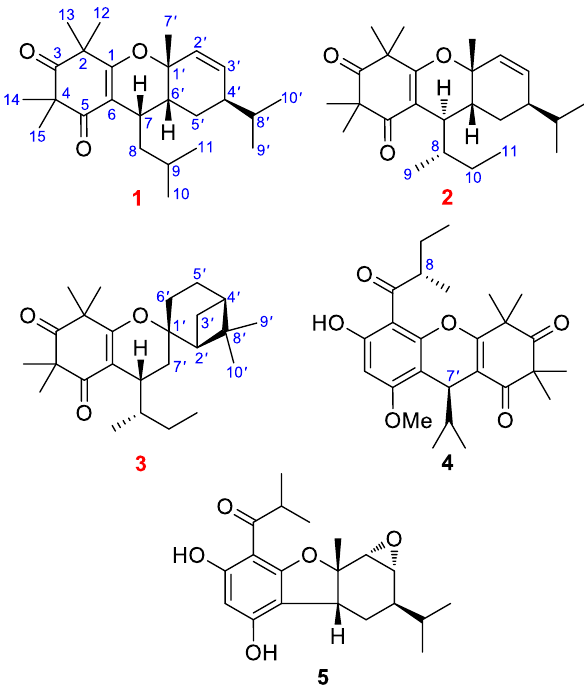
Fig. 1 Structures of 1 – 5 obtained from C.